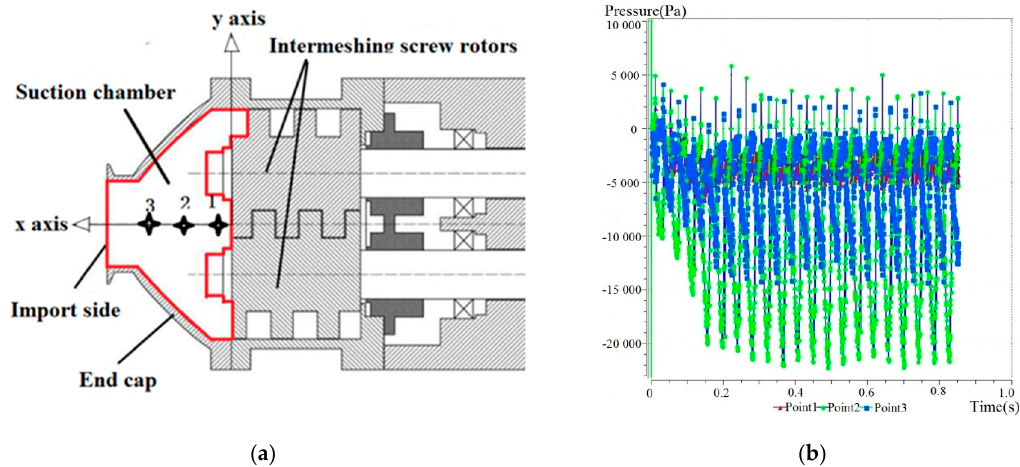
Figure 11. Pressure fluctuations on selected monitoring points for N = 1430 rpm. Total time: 0.86 s. ( a ) Selected monitoring point locations; ( b ) static pressure fluctuations at 3.6 m 3 / h. (b) Upstream boundary location e ff ects on numerical